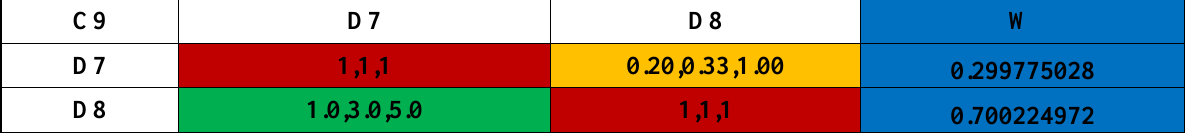
Table 12. The pairwise comparison matrix, C